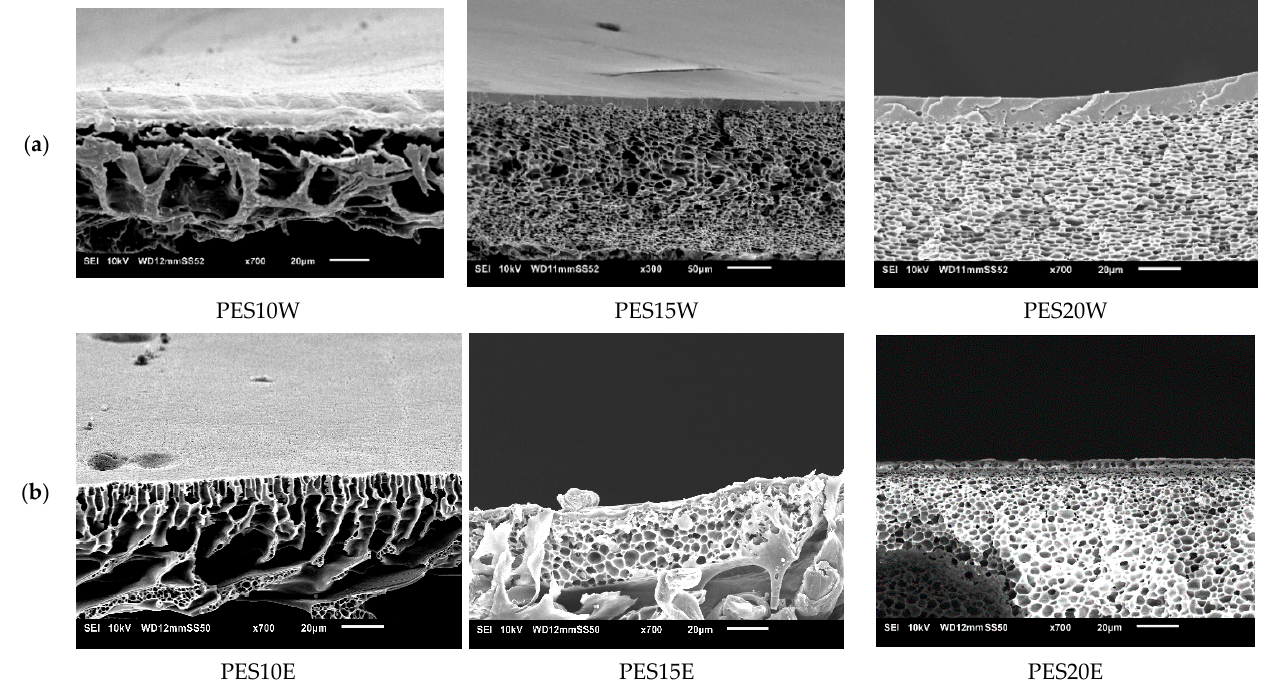
Figure 11. Influence of PES concentration on cross-section of the SEM images of PES membranes cast from using ( a ) water as non-solvent and ( b ) ethanol as non-solvent.